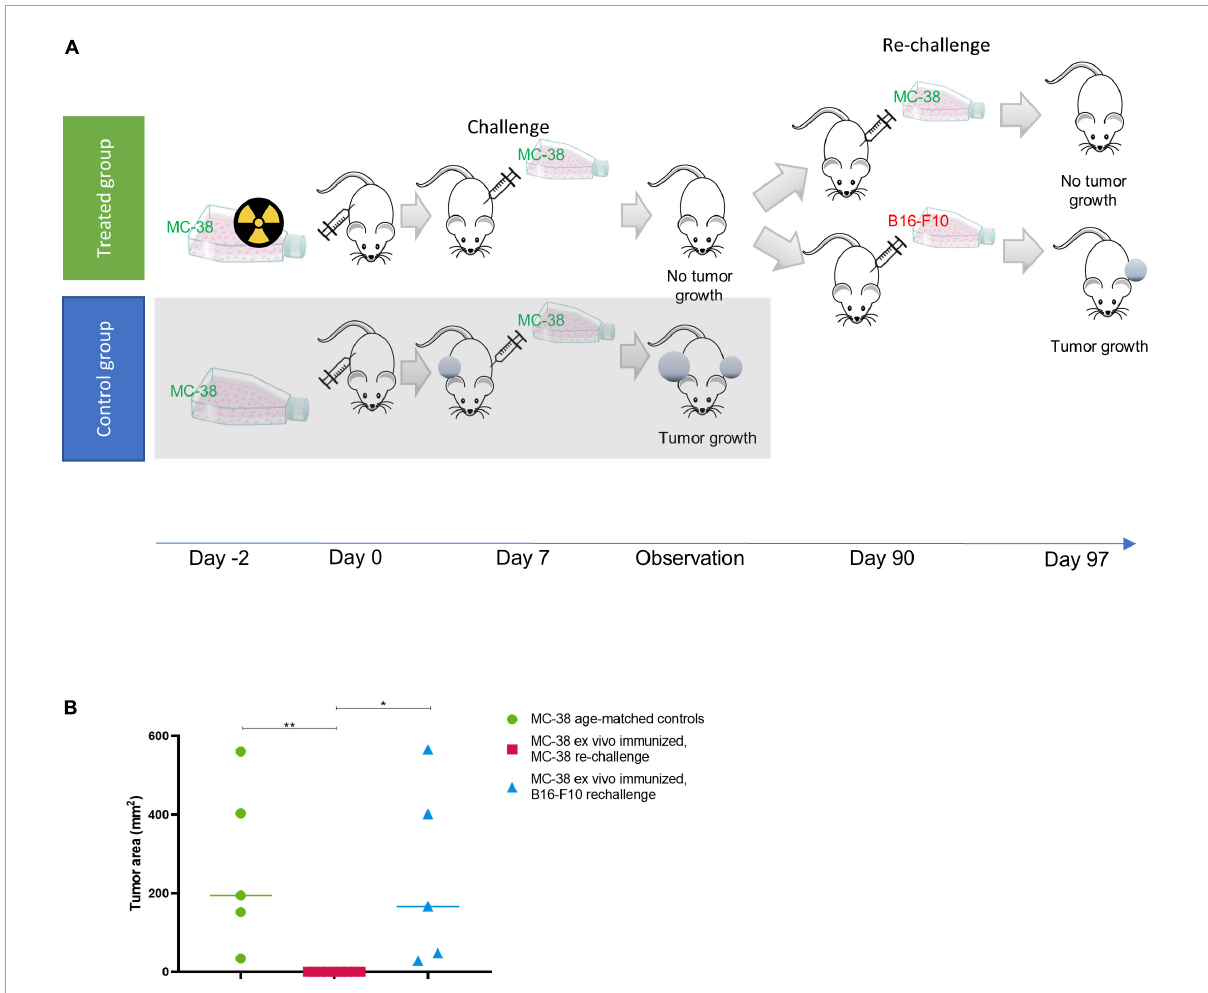
FIGURE2 Ex vivo immunization with irradiated MC-38 cells. (A) Scheme detailing ex-vivo immunization using targeted thorium-227 conjugates (TTC) irradiated MC-38 cells. In brief, mice were implanted with MC-38 cells pretreated with alpha radiation ( n = 10), or with healthy MC-38 cells to serve as control ( n = 5). The mice were then challenged with a new MC-38 implantation after 7 days, and the mice that did not develop tumor were rechallenged once again after 90 days using MC-38 or the unrelated B16-F10 cell line ( n = 5). (B) Size of tumors at day of sacrifice in each treatment group. 0 indicates no measurable tumor observed at sacrifice. Student’s T -test, * p < 0.05 and ** p <